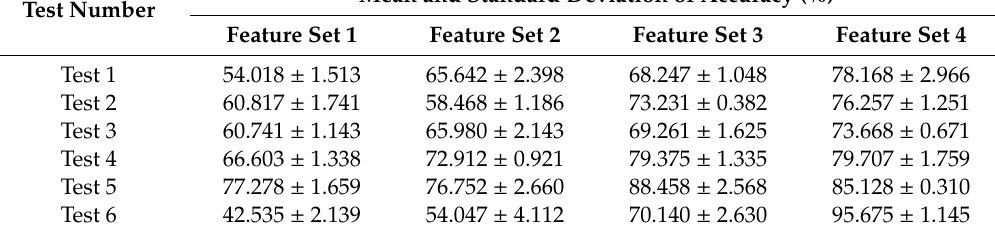
Table 7. Accuracy (mean and standard deviation, %) of external testing with 10 independent and random trials.